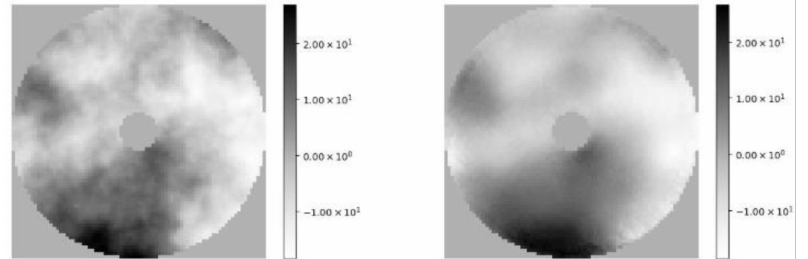
Figure 7. Comparison of a sample of the test set with r 0 of 8 cm for the FCN model. On the left, the original turbulence phase simulated and, on the right, the one obtained by the FCN. In this case, the values between the images are similar corresponding with lower WFE seen in the